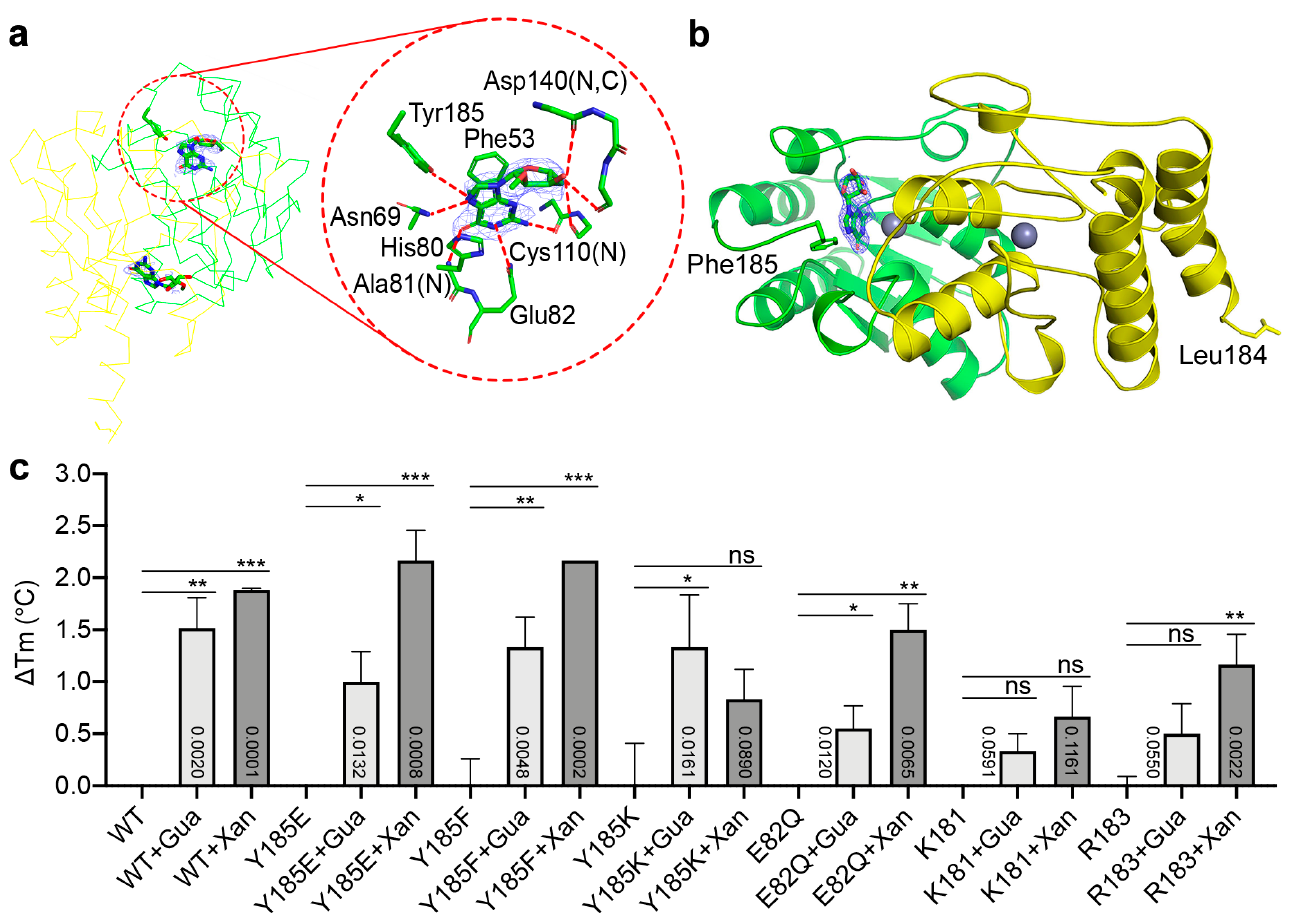
Figure 5. Binding modes of different substrates by the catalytically impaired mutants. ( a ) The E82Q-2 (cid:48) -O-methylguanosine complex structure (PDB 7W1Q). Shown on the left is the AtGSDA dimer represented in the backbone traces. The ligands and the electron density are shown. On the right is the closeup view of the interaction network of the 2 (cid:48) -O-methylguanosine, which resembles the substrate-binding mode, including the interactions on the ribose. ( b ) The Y185F mutant in complex with the substrate (PDB 7DQN). The last residues of the two chains are shown in sticks and labeled. ( c ) The guanosine and xanthosine binding capabilities of the mutants. Error bars are s.d. ( n = 3 biological replicates). Statistical evaluation with ANOVA is followed by Tukey’s post test. Probability values for pairwise comparisons to the group of apo-protein respectively, are shown at the respective bars. *: p < 0.05, **: p < 0.01, ***: p < 0.001. ns: no significance. The omit maps are contoured at 3 σ